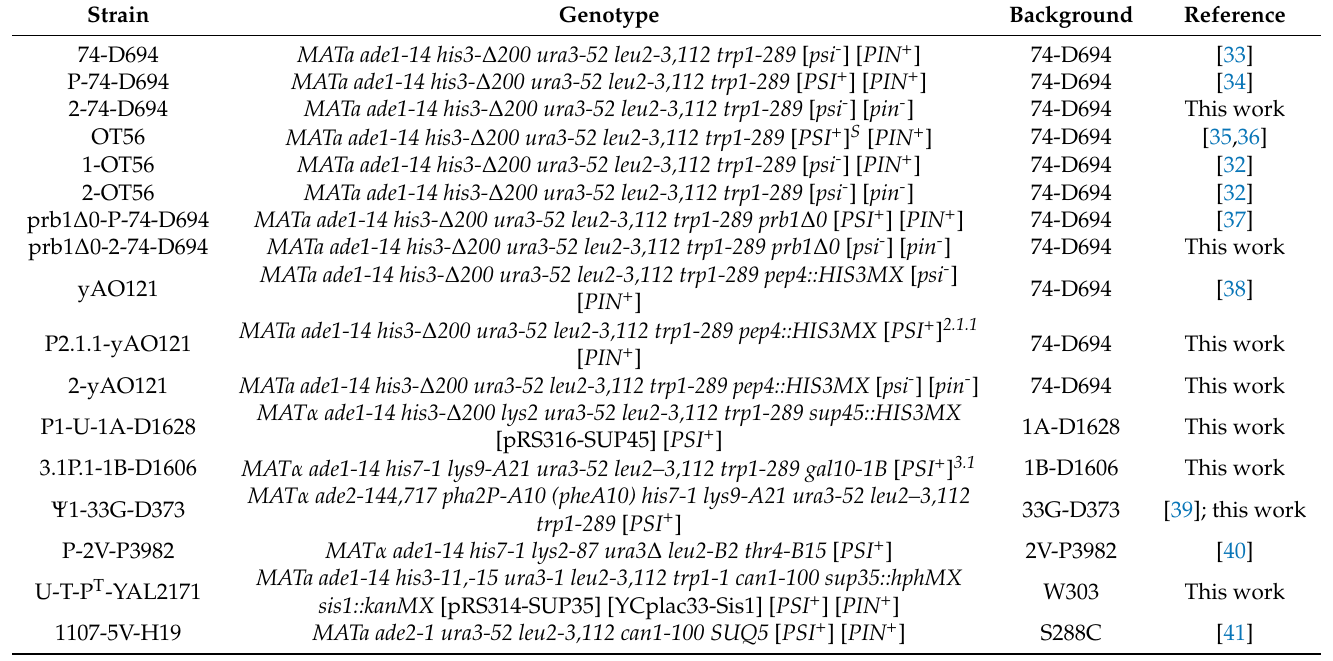
Table 1. Strains of S. cerevisiae used in this